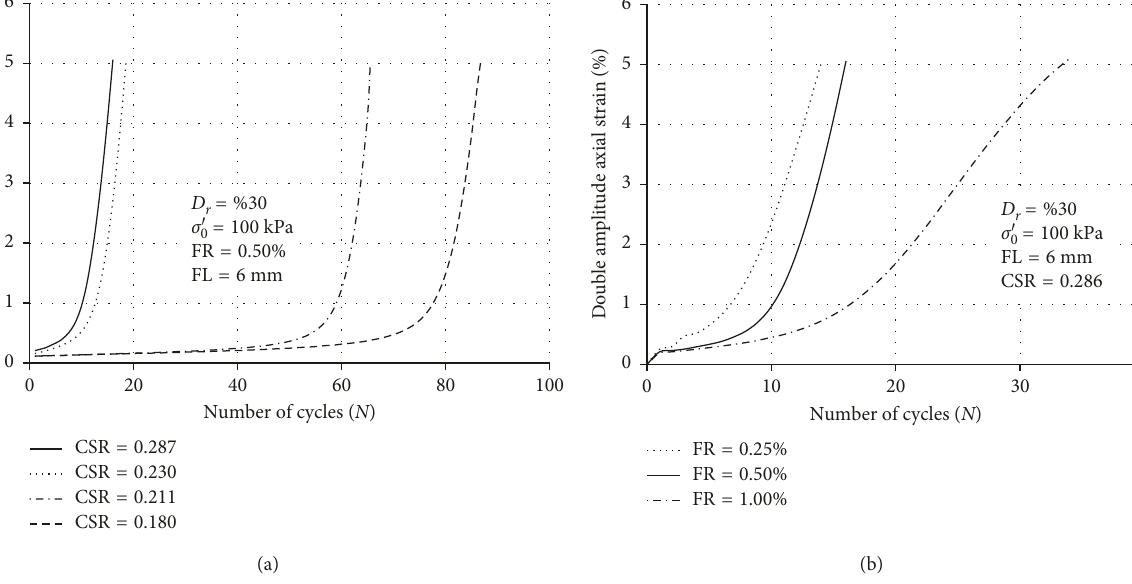
Figure 15: Variation of double-amplitude axial strain with number of loading cycles for reinforced sand. (a) Comparison of CSR values. (b) Comparison of fiber